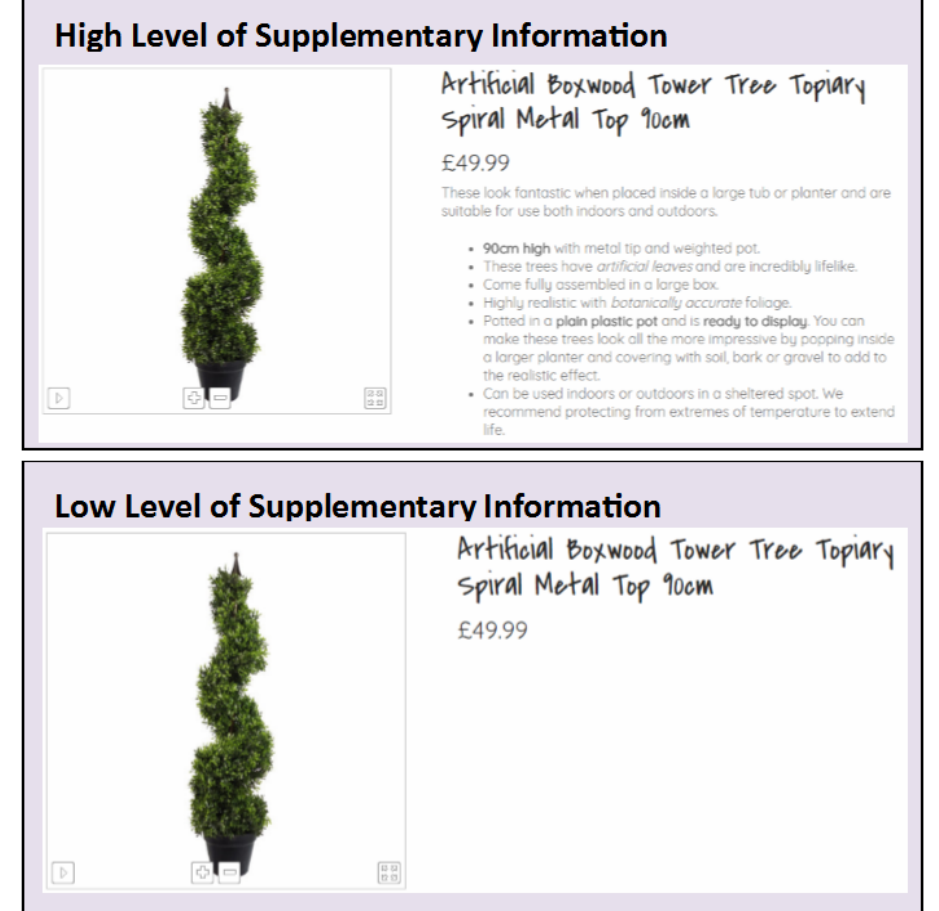
Figure 2. Supplementary information high/low.